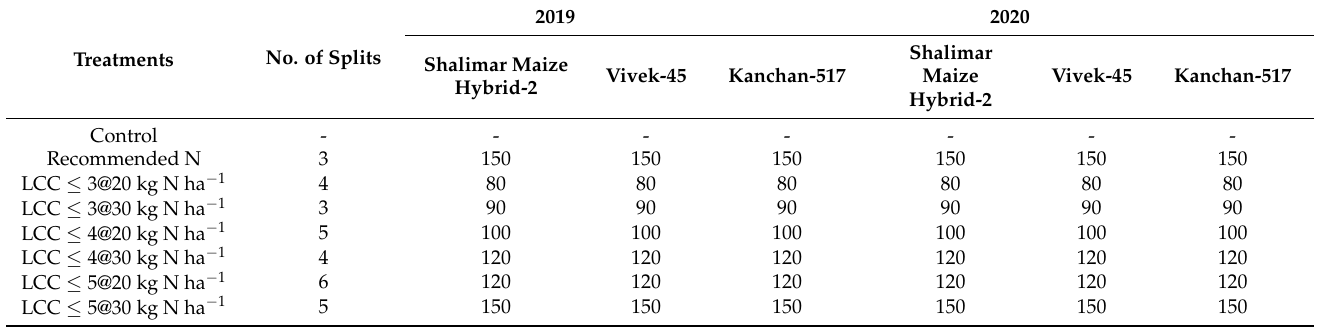
Table 2. Treatment wise splits and quantity of nitrogen applied in maize crop during 2019 and